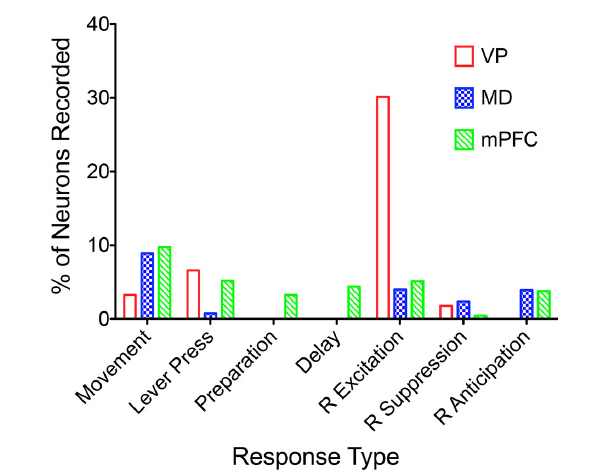
FIGURE 7 | The percentage of units recorded that meet the criteria for an isolated neuron that also meet criteria for specific response types (see Francoeur and Mair, 2018). Movement and lever press types are combined into single categories. Results are compared for ventral pallidum (VP), mediodorsal thalamus (MD), and medial prefrontal cortex